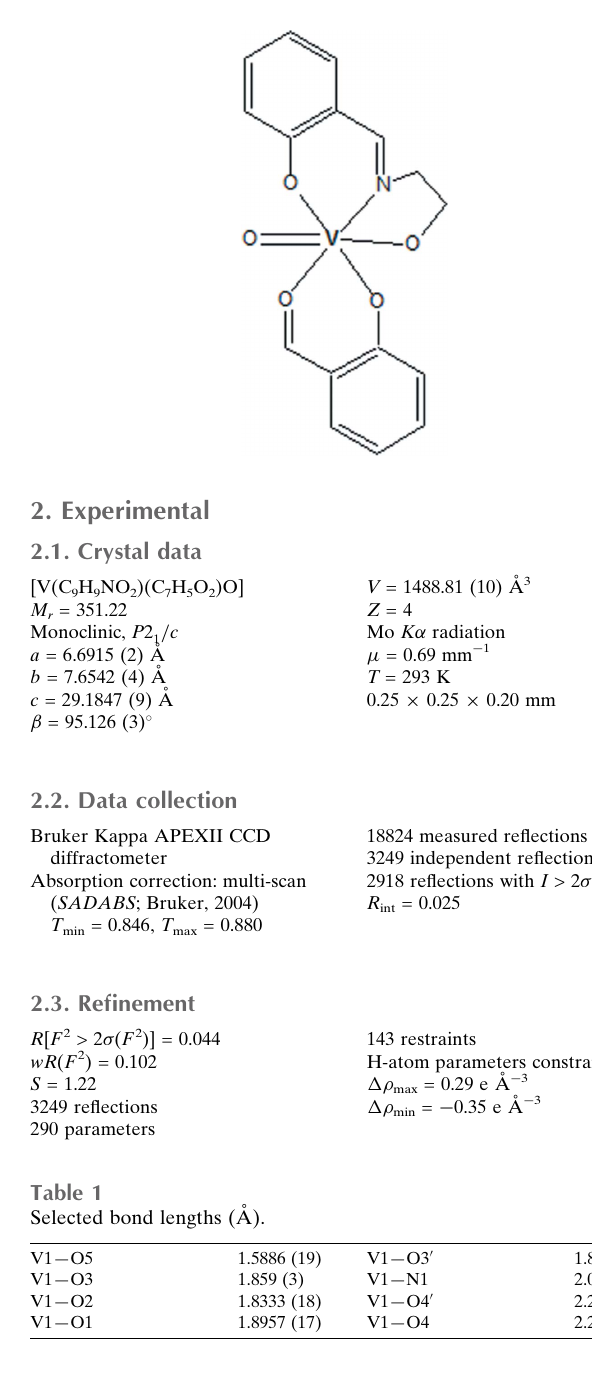
Hydrogen-bond geometry (A˚ , (cid:2)